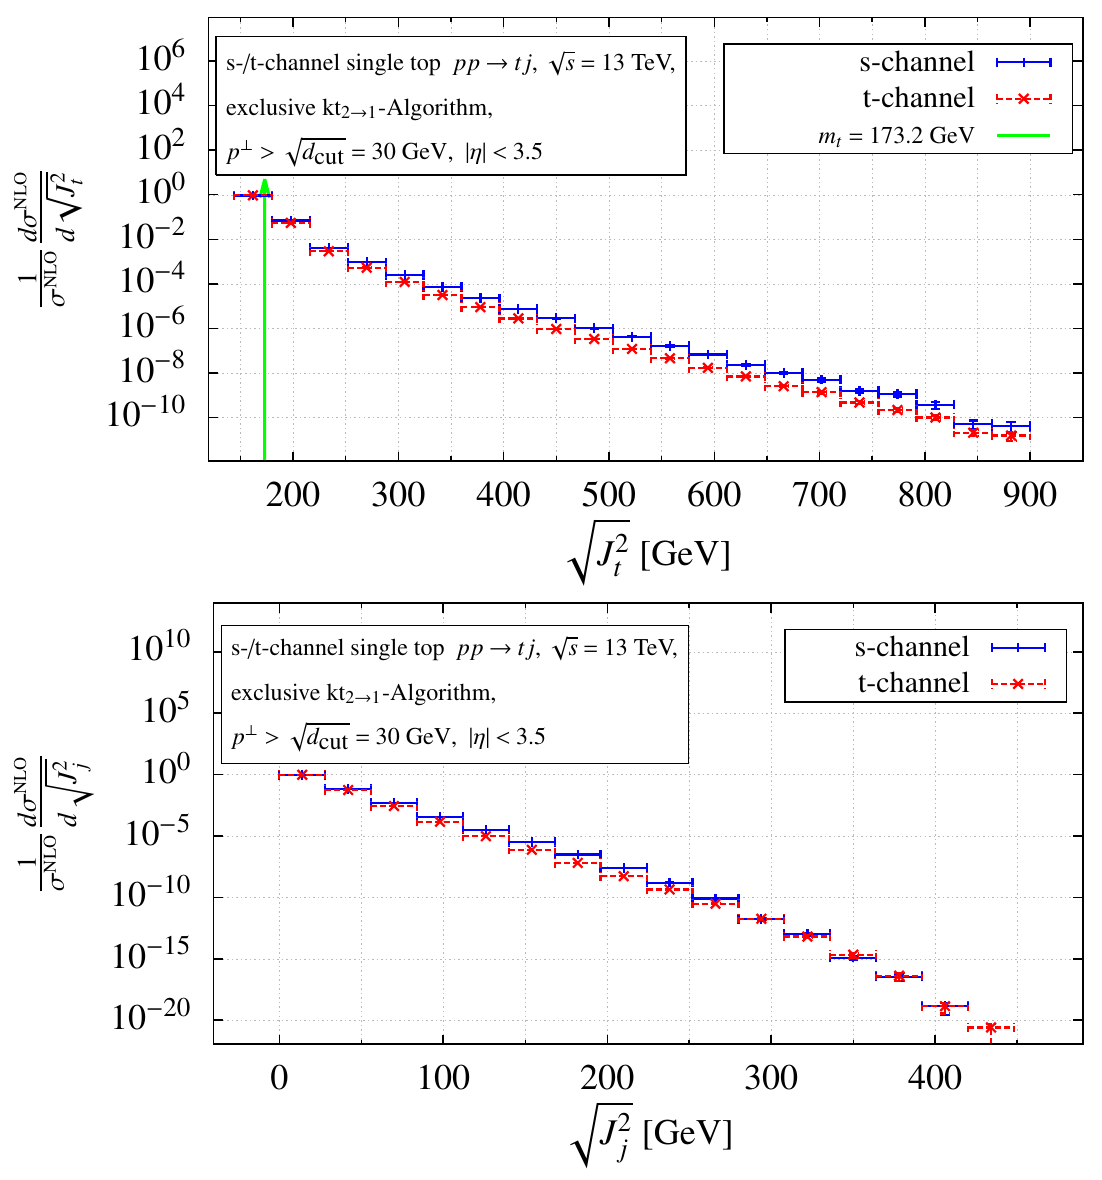
Figure 6 . Distribution of the jet masses for 2 ! 1 jet